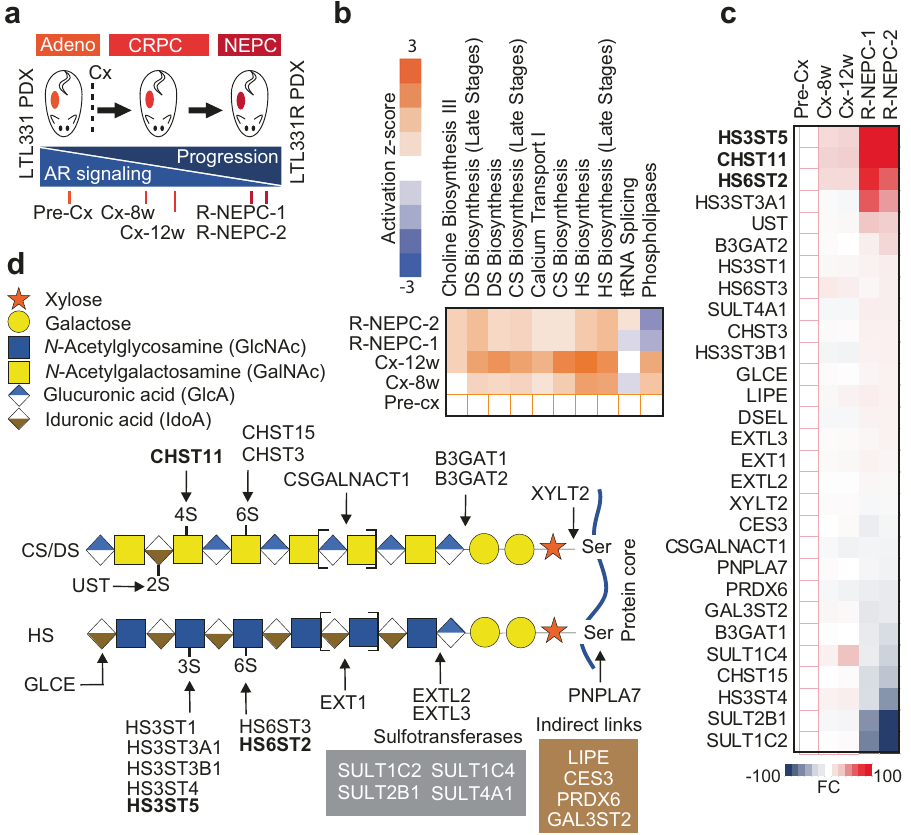
Fig.1|Castrationaltersexpressionofglycosaminoglycanenzymesinapatient- derived xenograft model of prostate cancer progression. a Overview of the LTL331 PDX model and schematic depicting time points at which tumors were collected. b IPA-ingenuity analysis on RNA-Seq data from LTL331 transdifferentia- tion PDX model showing the top upregulated metabolic pathways. c Fold change